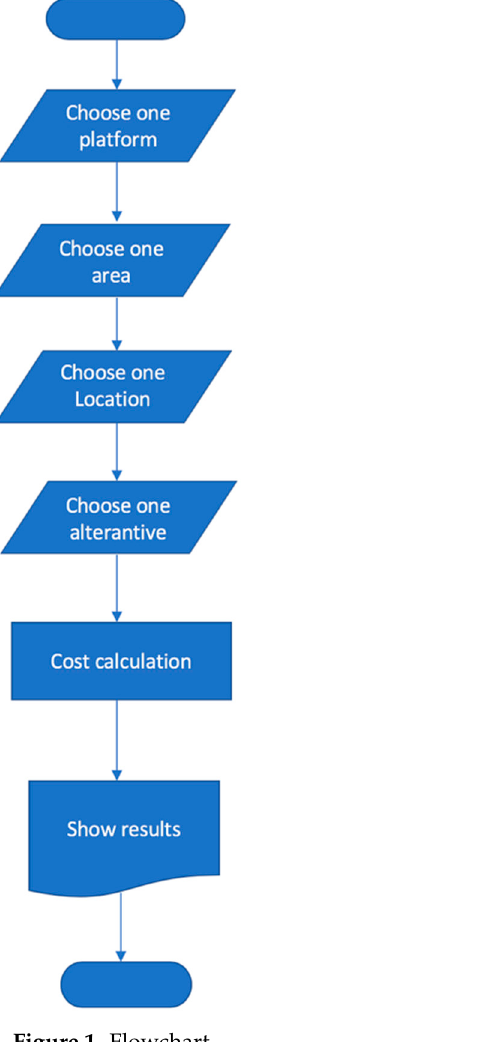
Figure 1. Figure 1. Flowchart.